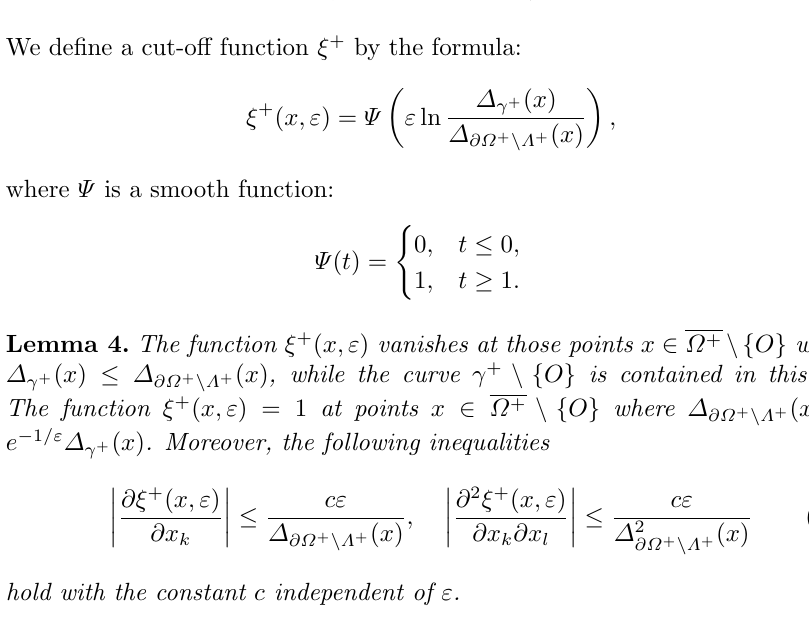
Figure 3. The curve γ +